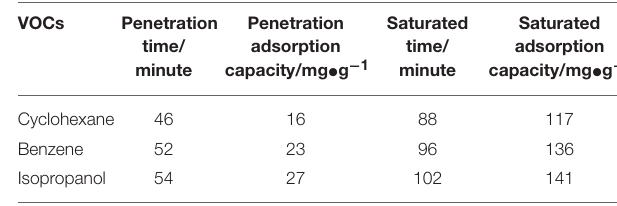
TABLE 5 | Adsorption performance of VOCs by zeolite X.